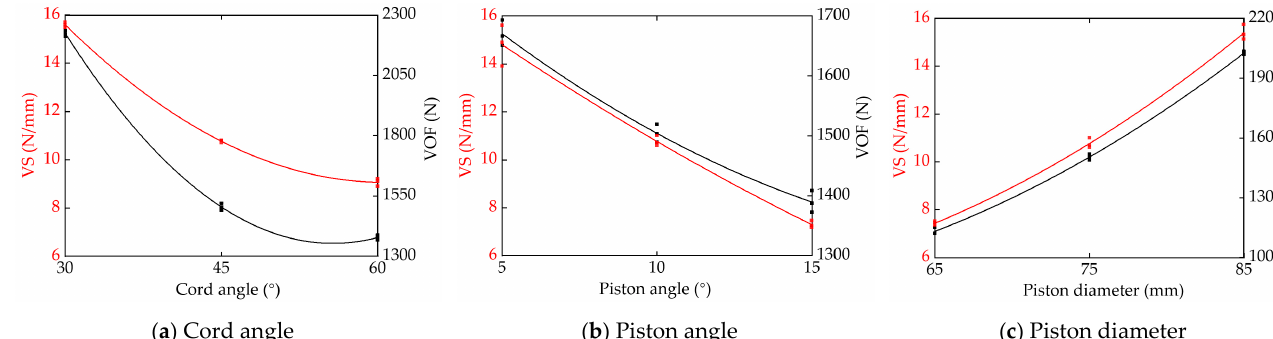
Figure 9. The fitting curve of VOF and VS.